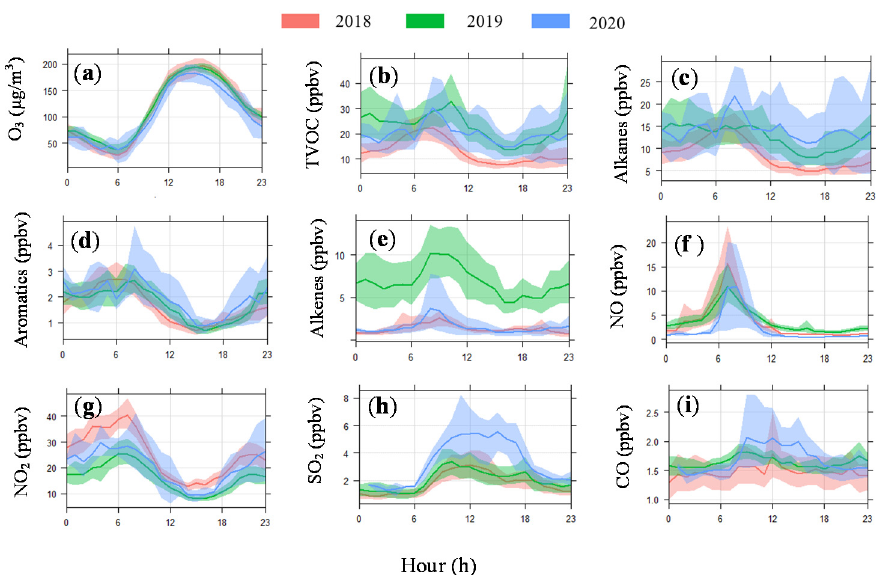
Figure 3. Diurnal variations of pollutants during O 3 episodes. ( a ) O 3 , ( b ) TVOC, ( c ) Alkanes, ( d ) Aromatics, ( e ) Alkenes, ( f ) NO, ( g ) NO 2 , ( h ) SO 2 , ( i ) CO. The concentration and proportion of 1-hexene (0.5 ppbv, 31.2%), ethylene (0.3